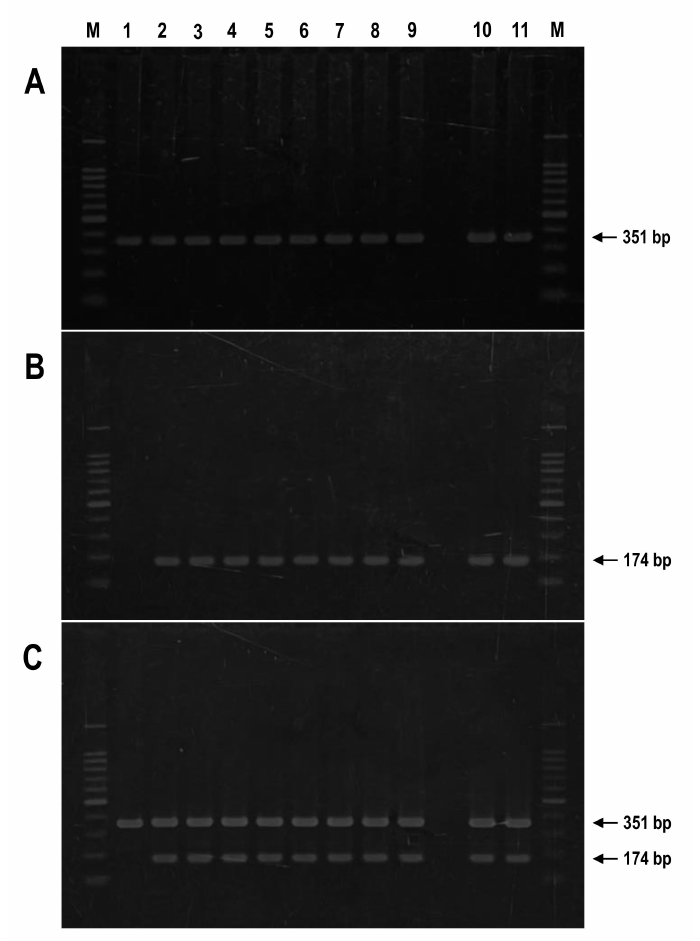
Figure 6. Electrophoretic detection of LHA2 and TUB2 genes amplified from single KTP-03-non- inoculated/inoculated leaf type I trichomes of tomato cv. Moneymaker (MM) via suc-PCR (RT- PCR/N-PCR) and multiplex RT-PCR/N-PCR, (for the detection of one and two genes, respectively). ( A , B ) The LHA2 gene from trichome cells ( A ) and TUB2 gene from KTP-03 ( B ) were amplified in the first round using an external primer pair (lhaRT-1/lhaRT-2 and tbRT-1/tbRT-2, respectively); this was followed by N-PCR using an internal primer pair, along with lhaN-1/lhaN-2 or tbN-1/tbN-2, respectively. ( C ) The LHA2 and TUB2 genes were amplified in Figure 1. (lhaRT-2 and